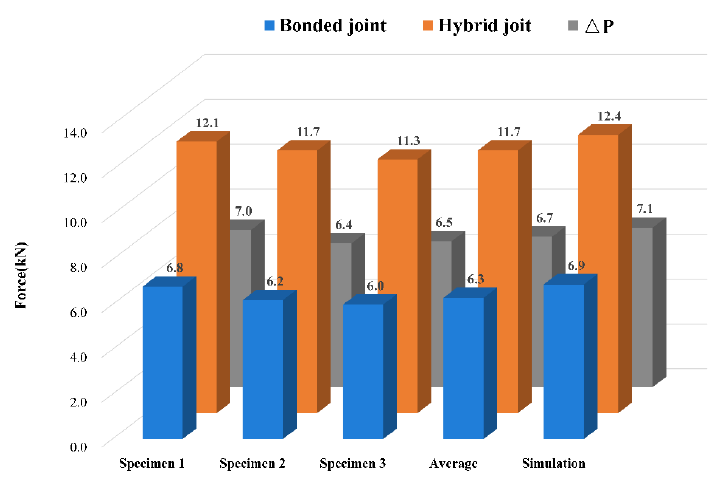
Figure 10. The comparison of the bearing capacity of the two kinds of joints.